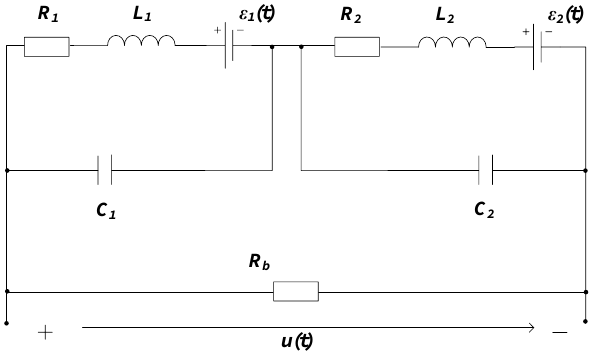
Figure 7. Model 2: Equivalent circuit model with a single damper resistance.